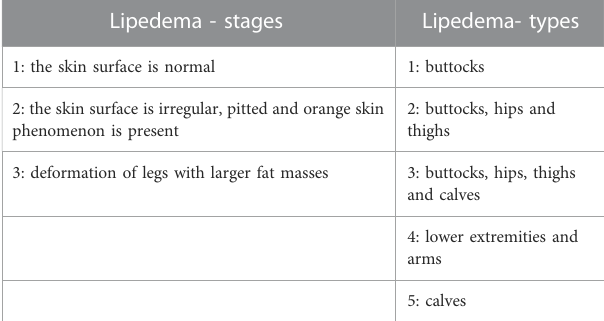
TABLE 1 Criteria of stages and types of lipedema used in the